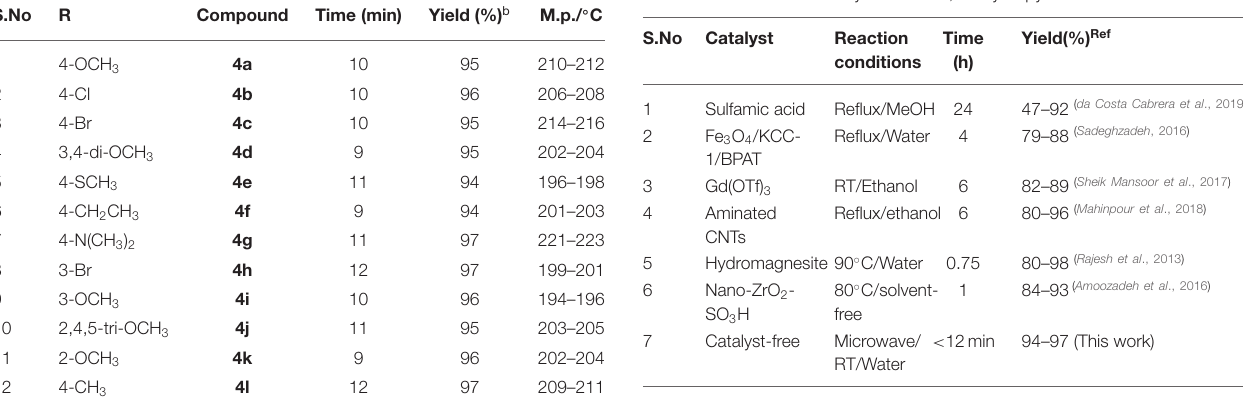
TABLE 3 | Synthesis of 1,2,4-triazole tagged 1,4-dihydropyridine scaffolds 4a-l a . TABLE 4 | Comparison of the current reported procedure with previously described methods for the synthesis of